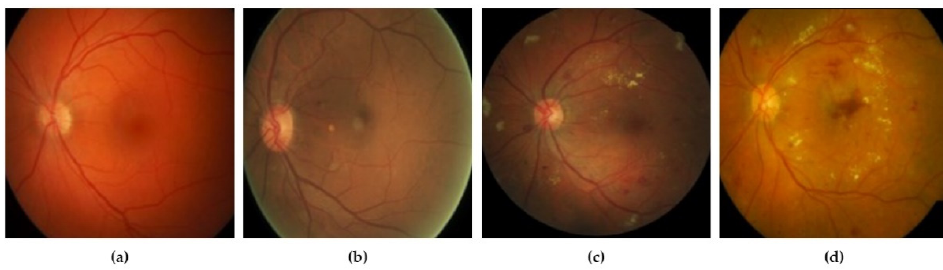
Figure 2. ( a ) Non-proliferative DR mild; ( b ) non-proliferative DR moderate; ( c ) non-proliferative DR severe; ( d ) proliferative DR [14].